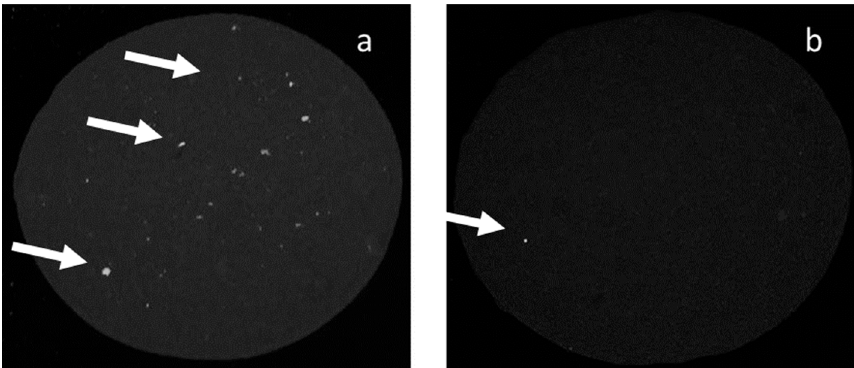
Figure 5. Effect of enzyme Lipase 30 G at different concentrations on the stickies. ( a , b ) control; ( c ) 0.11 g/L; ( d ) 0.22 g/L; ( e ) 0.33 g/L; and ( f ) 0.44 g/L. Large stikies are denoted by an arrow.